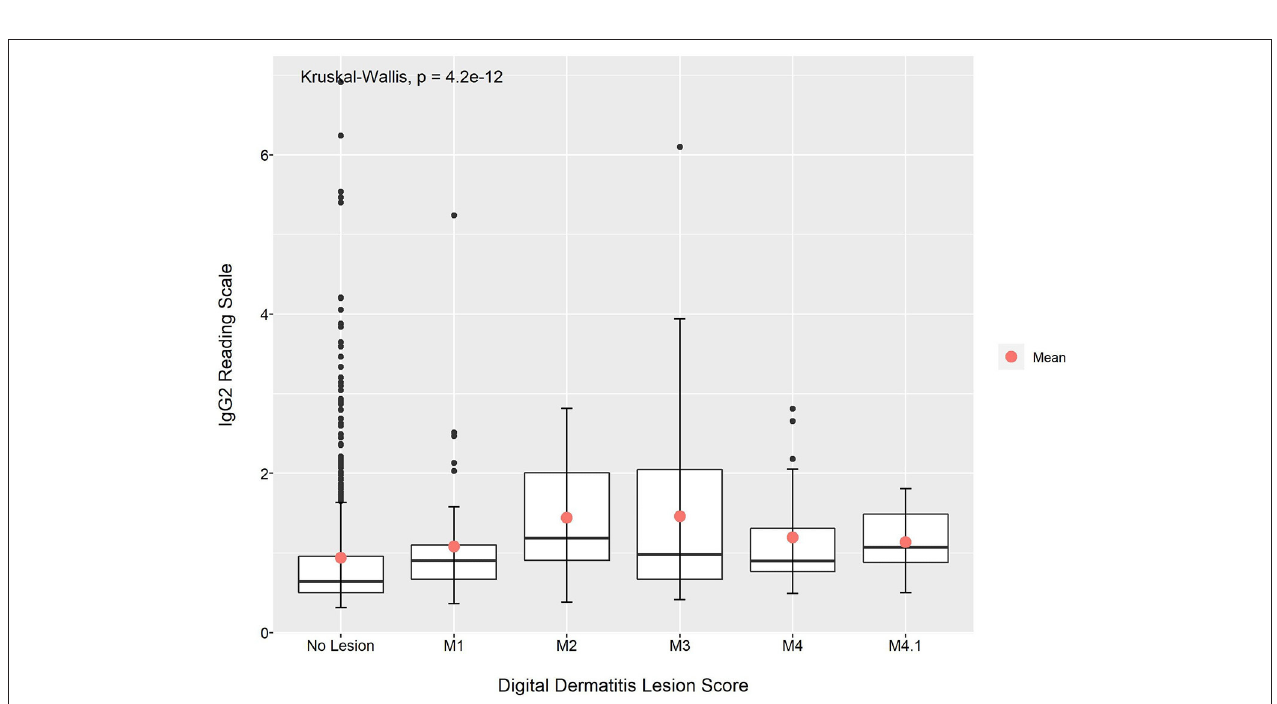
FIGURE 2 | Mean absorbance reading for IgG2 anti- Treponema antibodies across the different DD lesion scores.